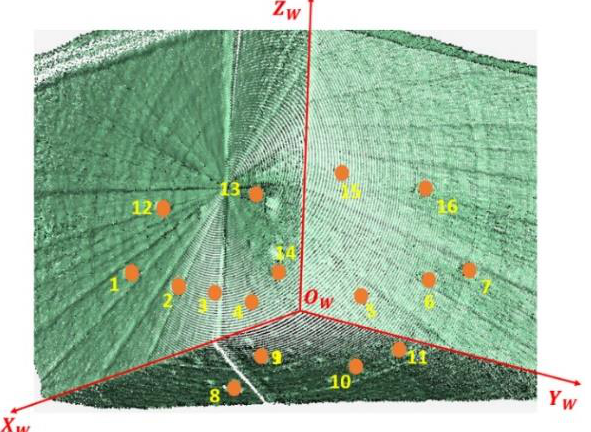
Figure 6. The 3D point cloud of the test field is generated with the proposed system and the fitted sphere to the points of the ping pong